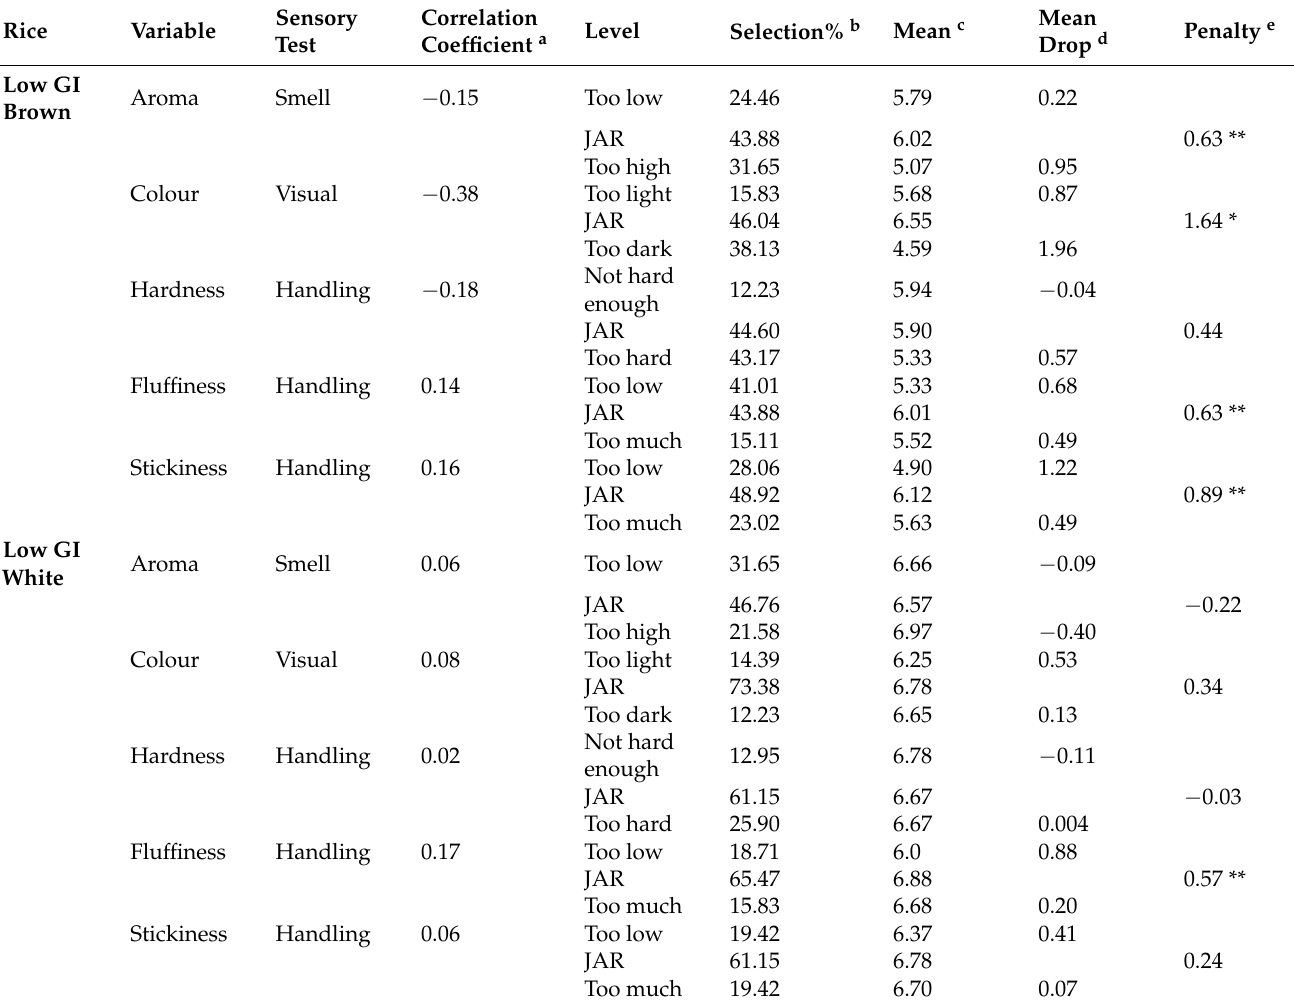
Table 6. The Penalty analysis and JAR variables (before tasting) for Low GI brown and white